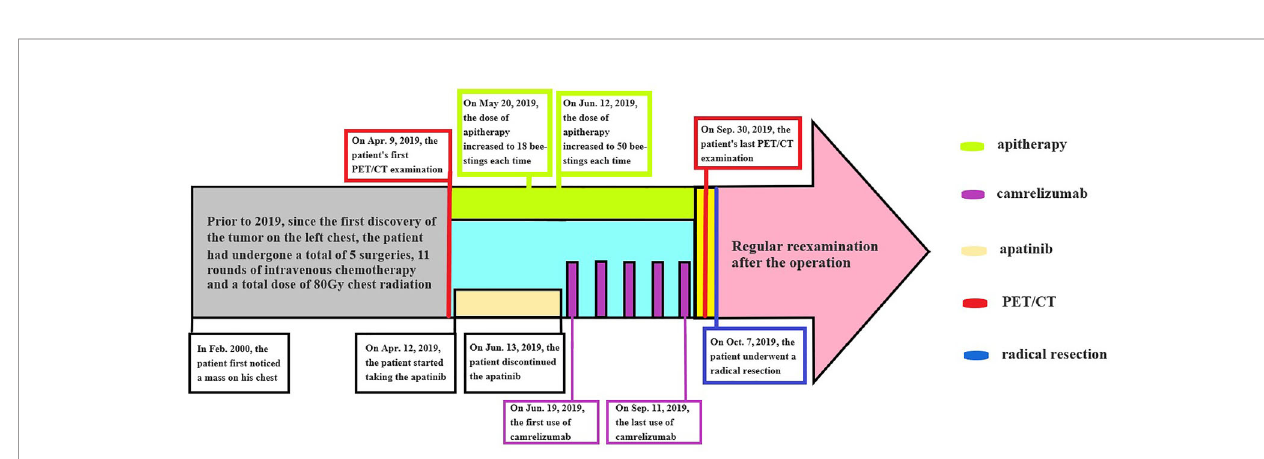
FIGURE 4 | (A) In the section with most residual tumor tissue, the tissue area was about 0.3 × 0.2 cm and the boundary (black arrows) between that tissue and the hyaline degeneration was distinct (hematoxylin and eosin staining, 100 × magni fi cation). (B) Many tumor cells were observed near remnant tumor tissue, but these gradually decreased in number in the distal areas (the direction shown by the black arrow, hematoxylin and eosin staining, 200 × magni fi cation). (C) The closer the transition zone of hyaline degeneration, the thinner the density of tumor cells (black arrows, residual tumor cells), and the greater the extent of necrotic degeneration (white arrow, hematoxylin and eosin staining, 200 × magni fi cation). (D) Complete hyaline degeneration (without residual tumor cells) was observed in all other sections (hematoxylin and eosin staining, 200 × magni fi cation).